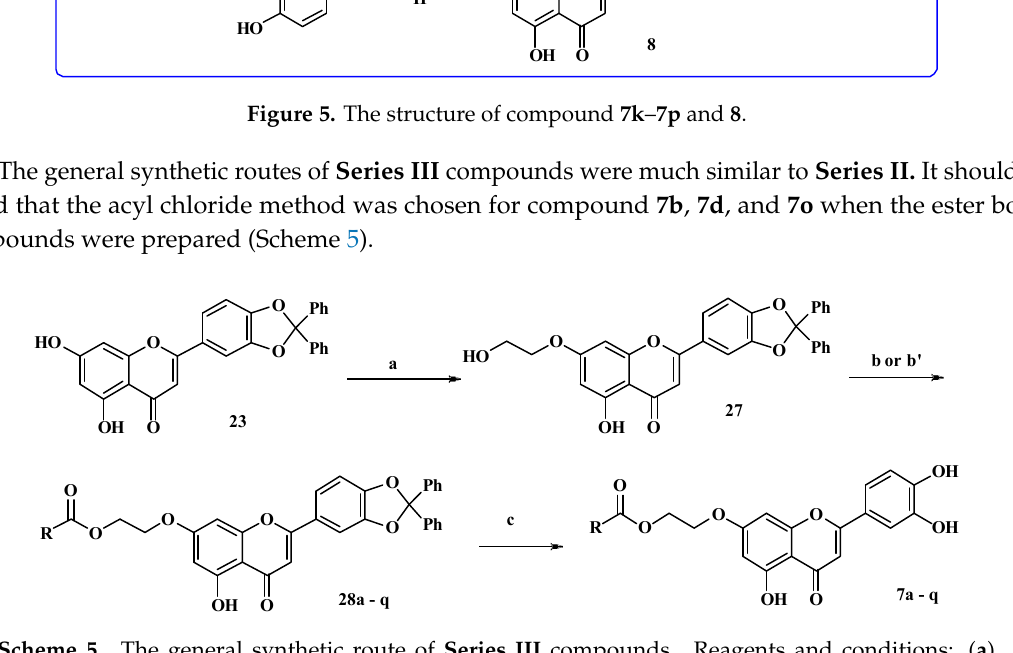
Table 4. The enzyme activity of Series Ⅲ compounds.